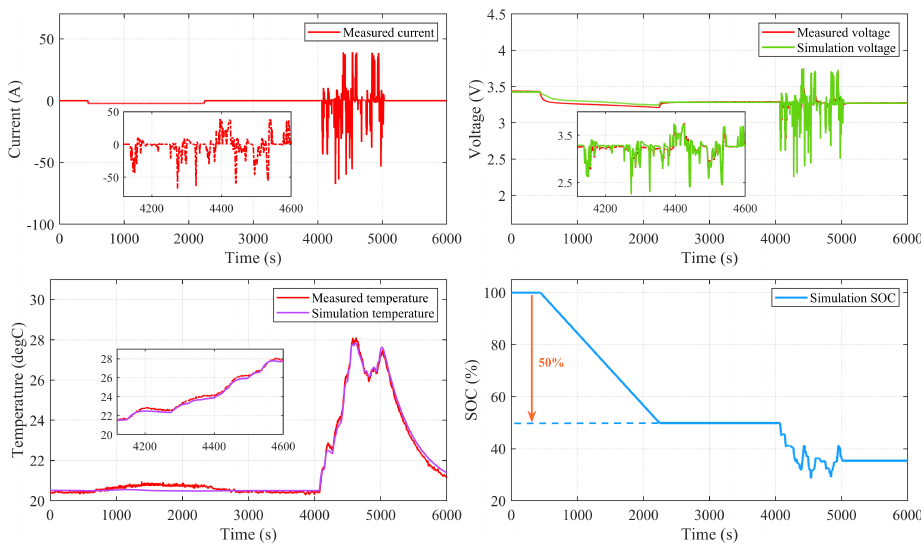
Figure 5. Test measurement and simulation results of 2.3 Ah battery cell (current, voltage, tempera- ture, and